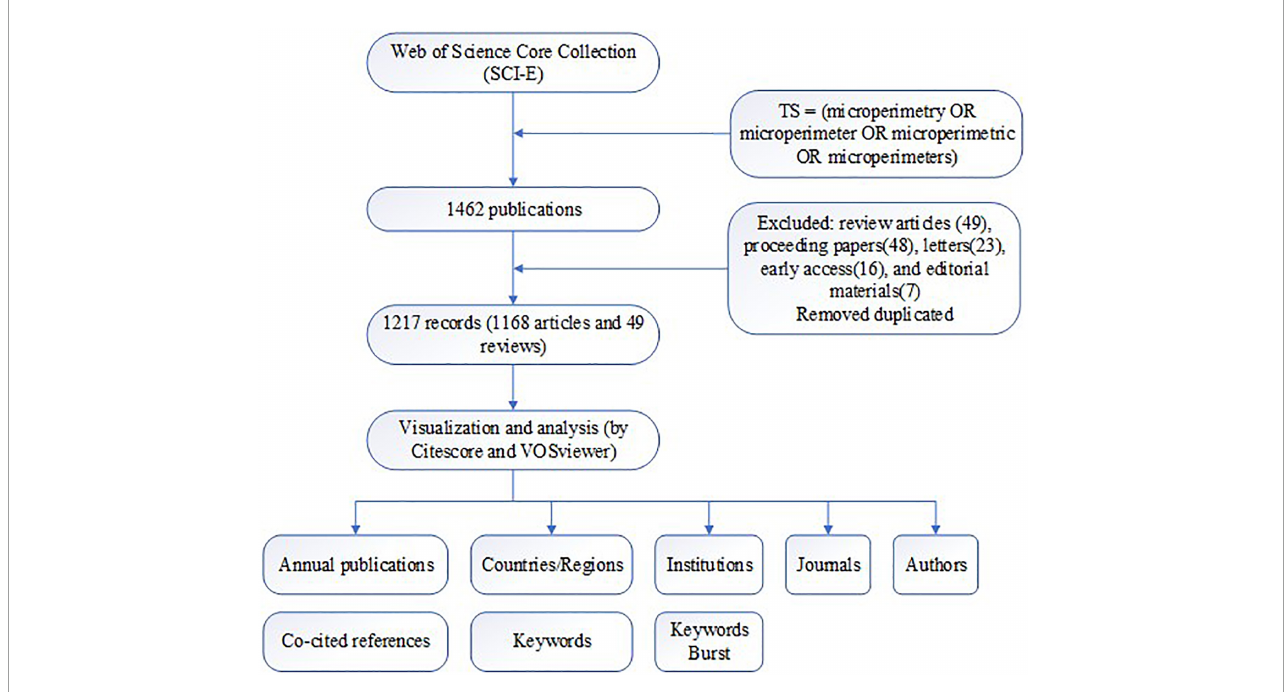
FIGURE1 Workflow of the